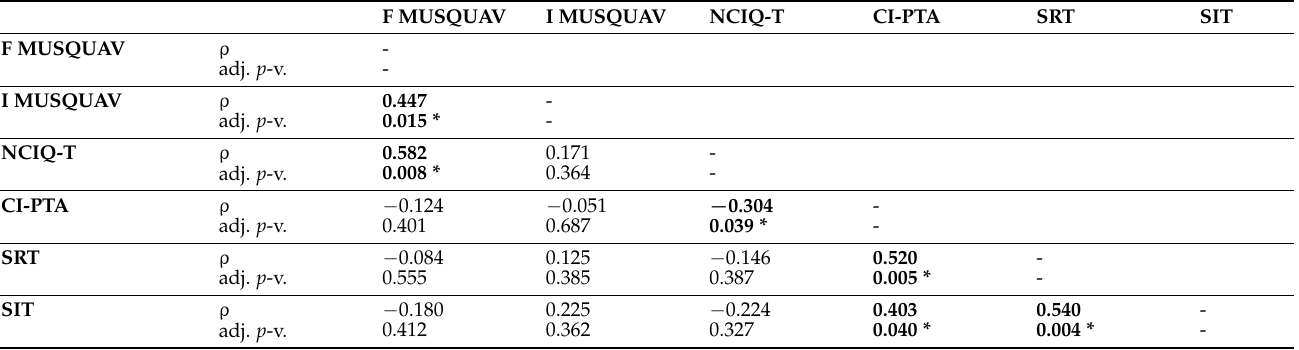
Table 4. Demographic, clinical characteristics, audiological outcomes, and PRO measures of the Descriptives—REHAB group.